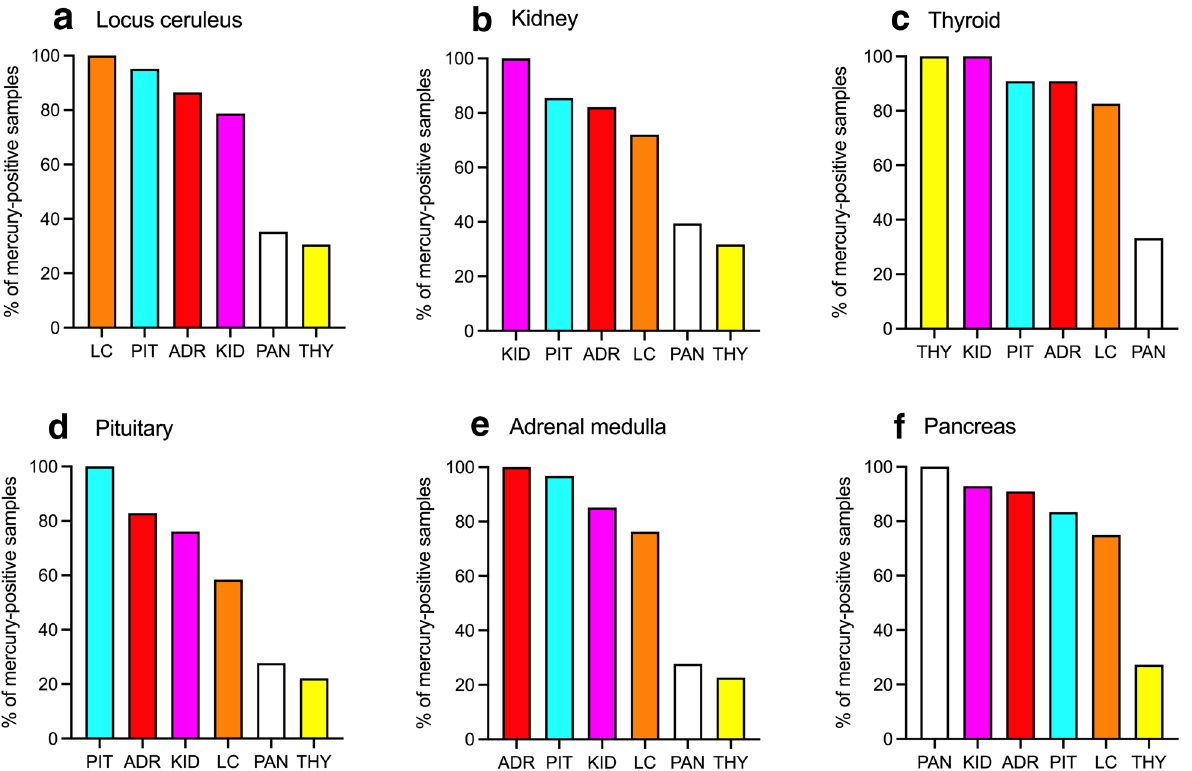
Figure 4. Mercury in concomitant organs. ( a ) When the locus ceruleus contained iHg, the pituitary, adrenal medulla and kidney often (i.e., more than 50% of the time) contained iHg as well. ( b ) When the kidney contained iHg, iHg was often present in the pituitary, adrenal medulla, and locus ceruleus. ( c ) If the thyroid contained iHg, four other organs often contained iHg. ( d ) When all pituitary samples contained iHg, iHg